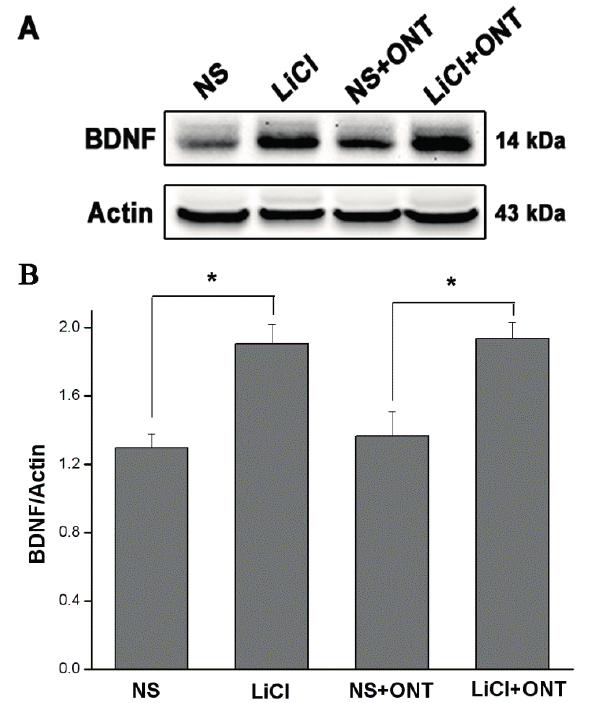
Figure 5. Western Blot assay and densitometric analysis showing the changes of the BDNF protein level of contralateral uninjured eyes and eye with ON transection (ONT) in LiCl (60 mg/kg·bw) and NS-treated groups at the 7 day point. ( A ) Representative picture of the immunoblot of BDNF protein in the LiCl and NS-control groups ( n = 3 for each treatment and group); ( B ) Quantitative analysis of Western Blot showing different protein levels of BDNF in the LiCl and NS groups. The asterisks indicate higher protein levels of BDNF ( * p < 0.01) in both the contralateral uninjured eyes and eyes with ON transection in the LiCl groups, when compared to those in the NS-control groups. Error bars =